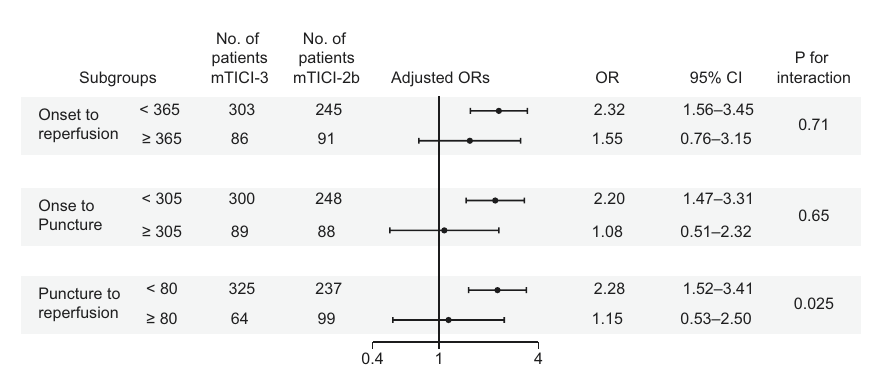
Figure 3. Adjusted odds ratios (ORs) of complete reperfusion (mTICI-3) for favorable outcome according to time course (onset-to-reperfusion, onset-to-puncture, and puncture-to-reperfusion time). These time variables are divided by the upper quartile. CI; confidence interval; mTICI, modified thrombolysis in cerebral